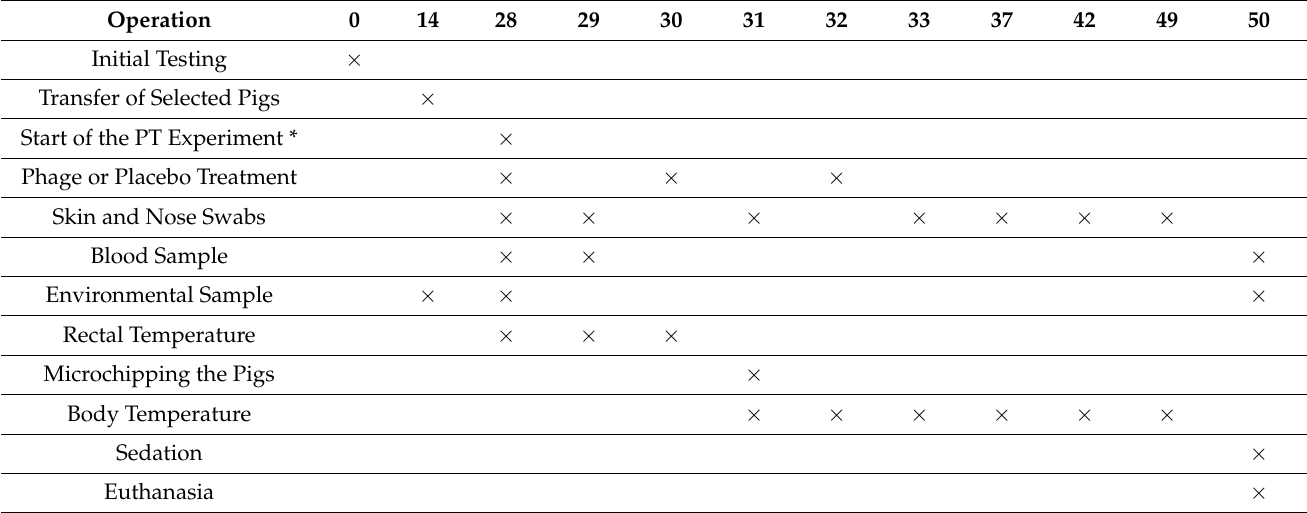
Table 1. The course of the phage therapy trial. Numbers indicate the day of the